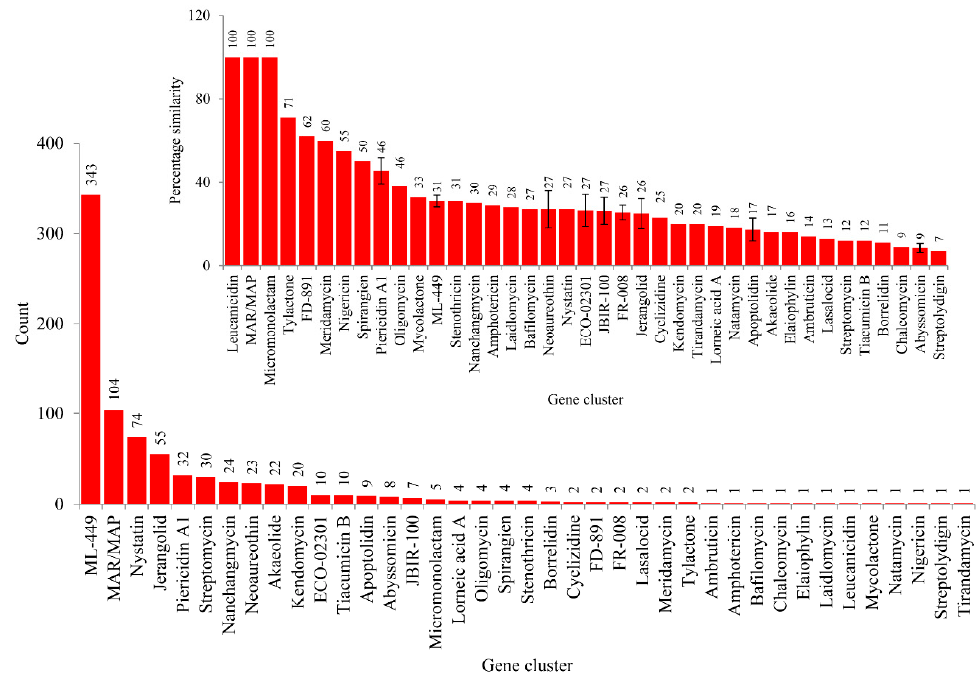
Figure 5. CYP139A P450 gene cluster analysis in mycobacterial species. The 39 gene clusters were presented with their standard abbreviated names as per anti-SMASH. The number next to bars represents the number of CYP139A P450s that is part of that gene cluster. The inset figure shows the percentage identity of CYP139A P450 gene clusters to the known gene clusters available at anti-SMASH. The number next to the bars represents the percentage identity. For some gene clusters the percentage identity is represented with standard deviation (indicated with bars).